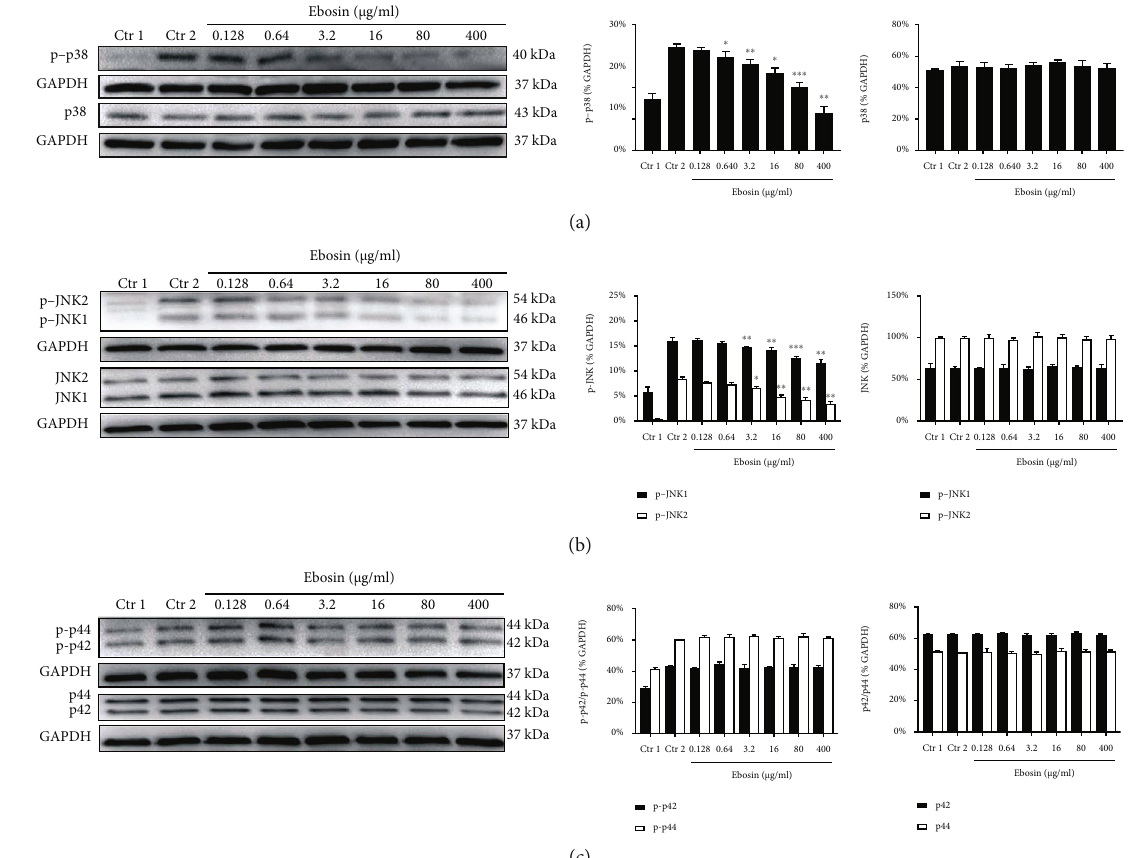
Figure 1: Ebosin inhibits the MAPK signaling pathway mediated by TNF- α in FLS. (a) E ff ect of ebosin on the phosphorylated and nonphosphorylated p38 MAPK separately. FLS cells ( 1 × 10 5 /ml ) were incubated in the presence or absence of ebosin for 12 h then with TNF- α (10 ng/ml) 15min. The phosphorylated and nonphosphorylated p38 MAPK were analyzed by western blot. (b) E ff ect of ebosin on the phosphorylated and nonphosphorylated JNK1 and JNK2 MAPK, respectively. The experimental protocol is the same as p38. (c) E ff ect of ebosin on phosphorylated and nonphosphorylated p42/44 MAPK (ERK1/2). The protocol is also the same as before. All of the data are expressed as the means ± SD from at least 3 independent experiments. P < 0 : 001 , P < 0 : 01 , and P < 0 : 05 compared to the control 2 (FLS incubated with TNF- α